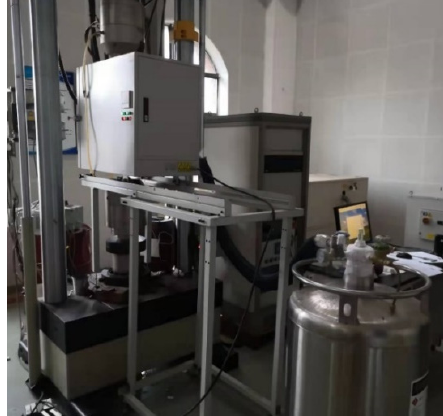
Figure 9. Experimental equipment.